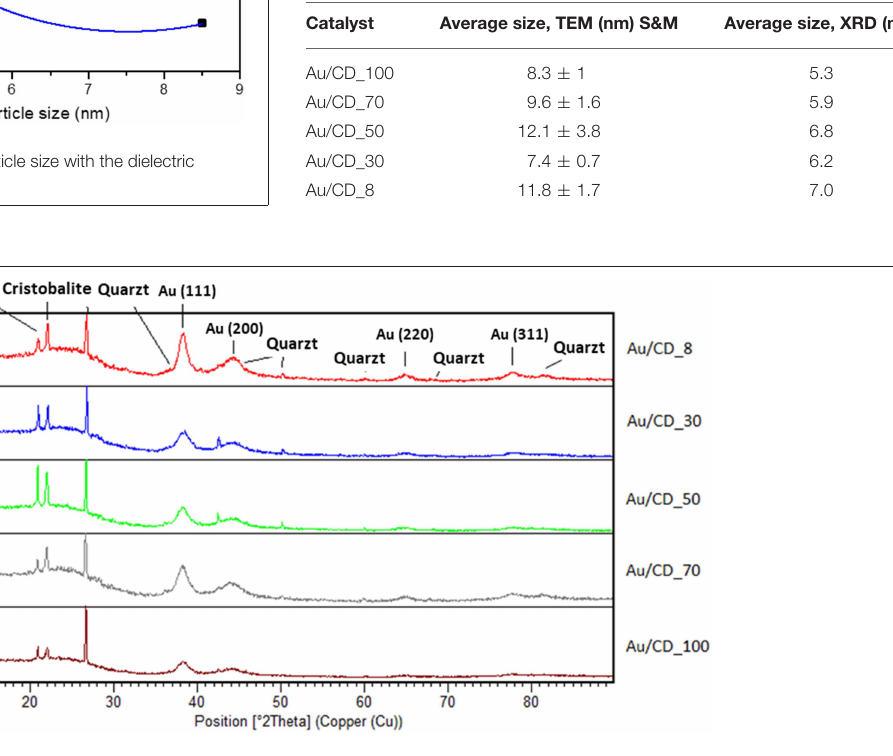
FIGURE 4 | Au/C catalysts